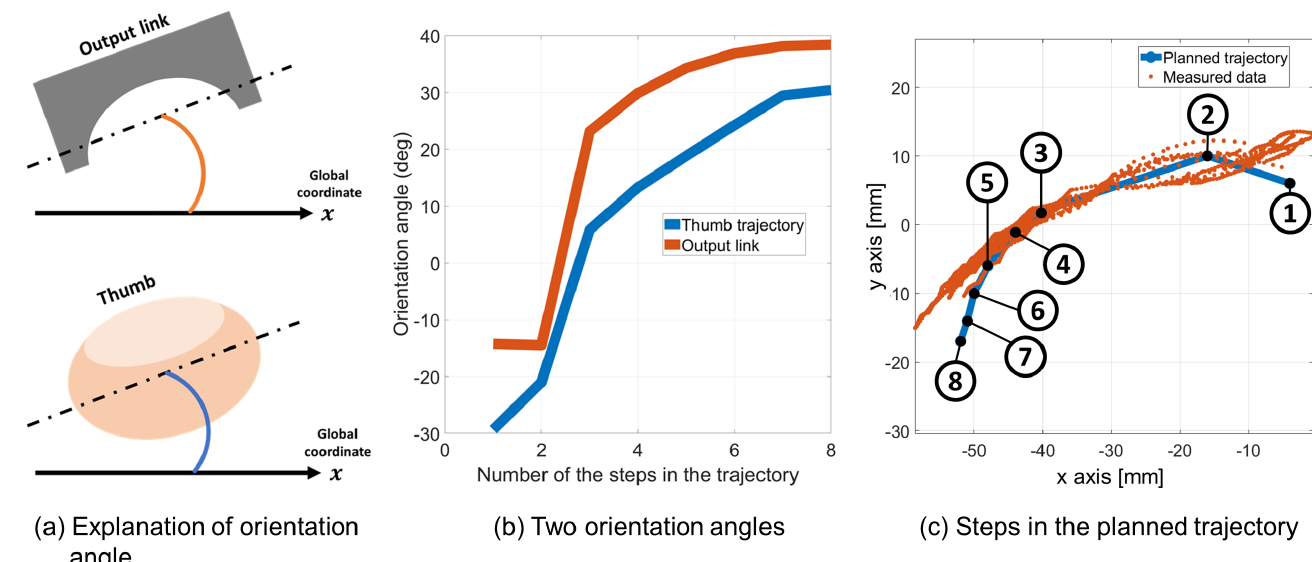
Figure 23. The orientation angles (around z axis in the xy plane) of the thumb measured data, and the output link of the experimental data and the explanation of the steps on the used planned trajectory: ( a ) explanation of orientation angle, ( b ) two orientation angles, ( c ) steps in the planned trajectory.